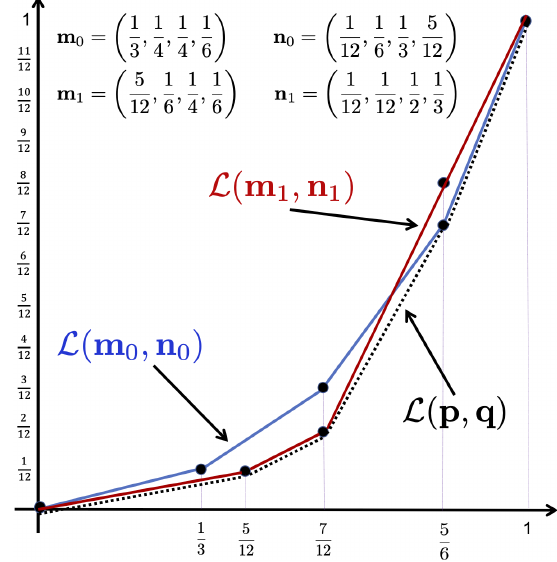
FIG. 2. Three lower Lorenz curves. The channels M , N ∈ CPTP ( X → Y ) with | X | = 2 and | Y | =